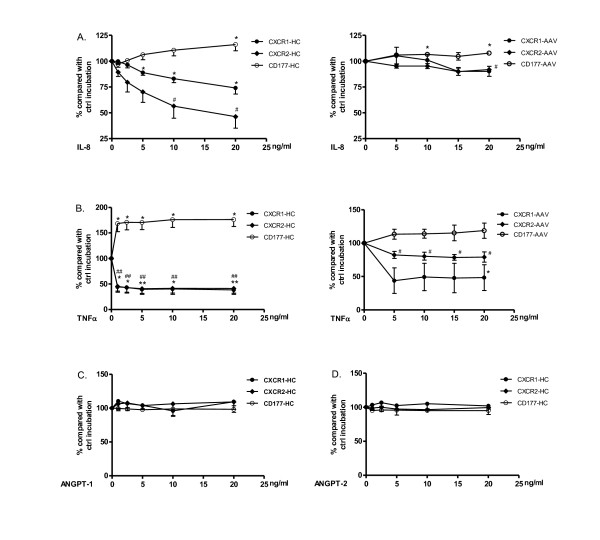
Down-regulation of CXCR1 and CXCR2 on neutrophils by IL-8 and TNFα. Isolated neutrophils from HC were pre-incubated with serial doses of IL-8 (A, left figure), TNFα (B, left figure), ANGPT-1 (C) or ANGPT-2 (D). Isolated neutrophils from AAV patients were pre-incubated with serial doses of IL-8 (A, right figure) and TNF α (B, right figure). Membrane expression of CXCR1 (black dots) and CXCR2 (black diamonds) was measured by flow cytometry. Expression of CD177 (open dots) was measured in parallel as control for stimulation. Results are presented as percentages compared to control incubation with normal medium (ctrl). CXCR1 and CXCR2 are equally down-regulated by TNFα (overlapping graphs in panel B). Results are the mean (± SD) of three experiments, *, P < 0.05; **, P < 0.01 (CXCR1 and CD177). #, P < 0.01 (CXCR2). AAV, ANCA-associated vasculitides; ANCA, anti-neutrophil cytoplasmic autoantibody; ANGPT, angiopoietin; IL; interleukin; TNF, tumor necrosis factor.